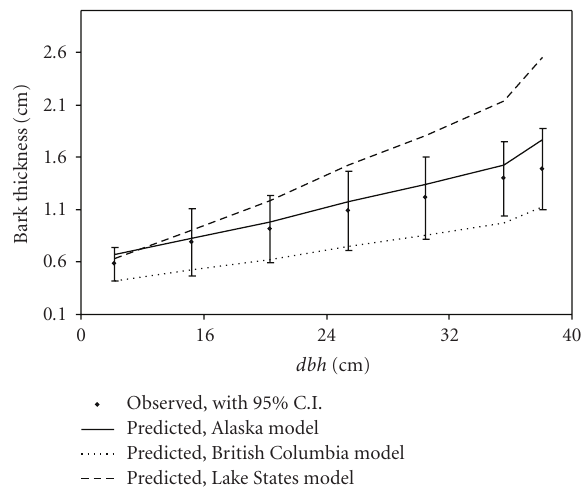
Figure 4: Average predicted and observed (with 95% confidence interval) bark thickness (cm), on 247 post-sample white spruce trees in Alaska. Predictions were obtained with British Columbia model, Lake States model, and the Alaska model presented here.